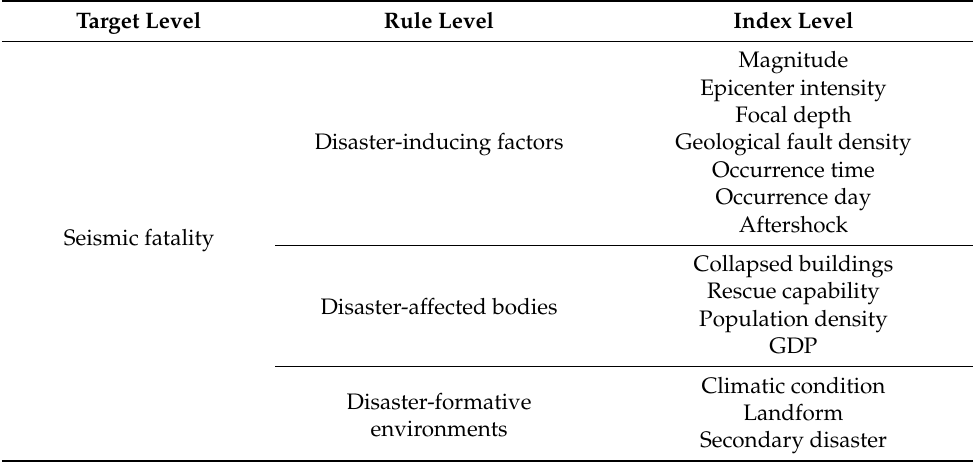
Table 3. Evaluation index system of features that influence earthquake